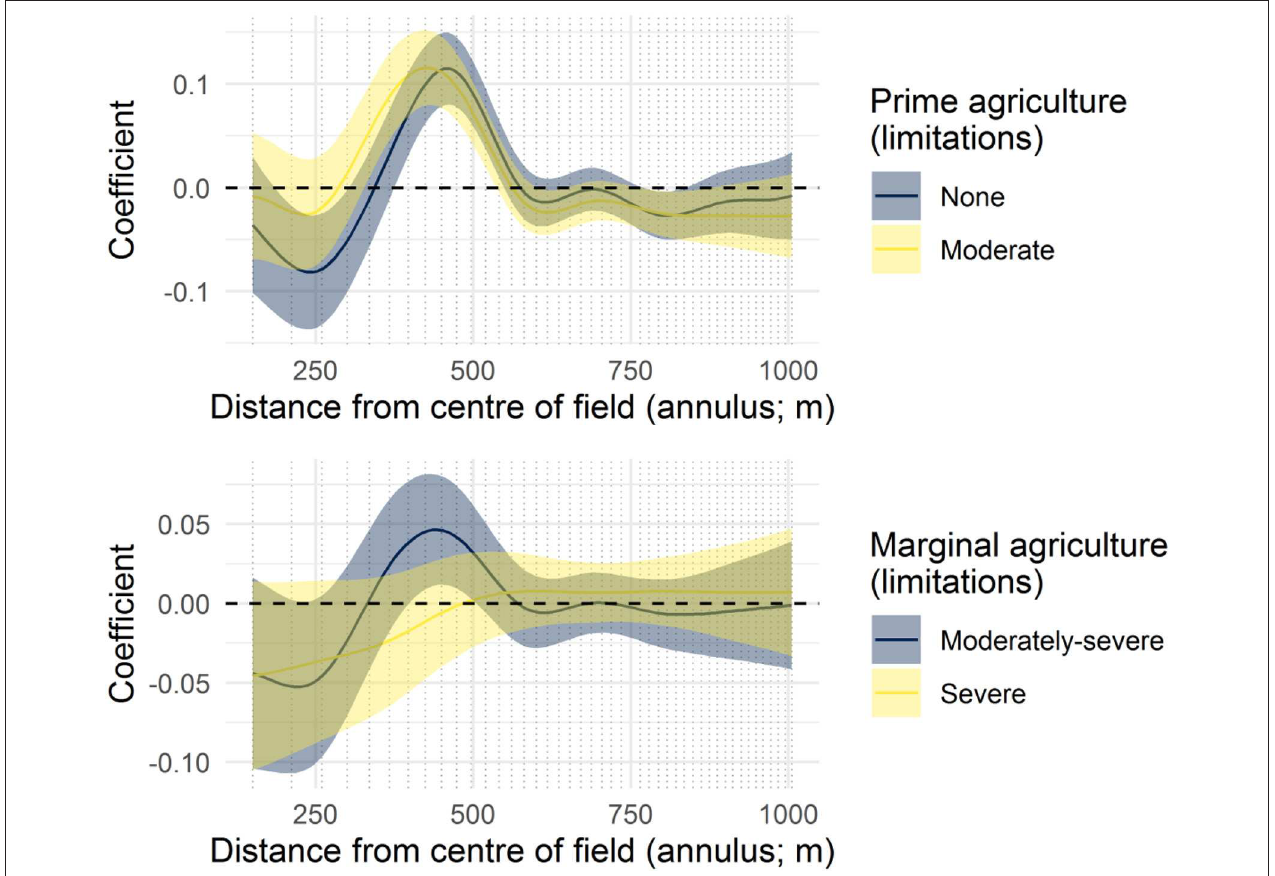
FIGURE 6 | The coefficient functions for four agricultural limitation classes. Curves demonstrate deviations from the mean landscape complexity curve ( Figure 3 ).